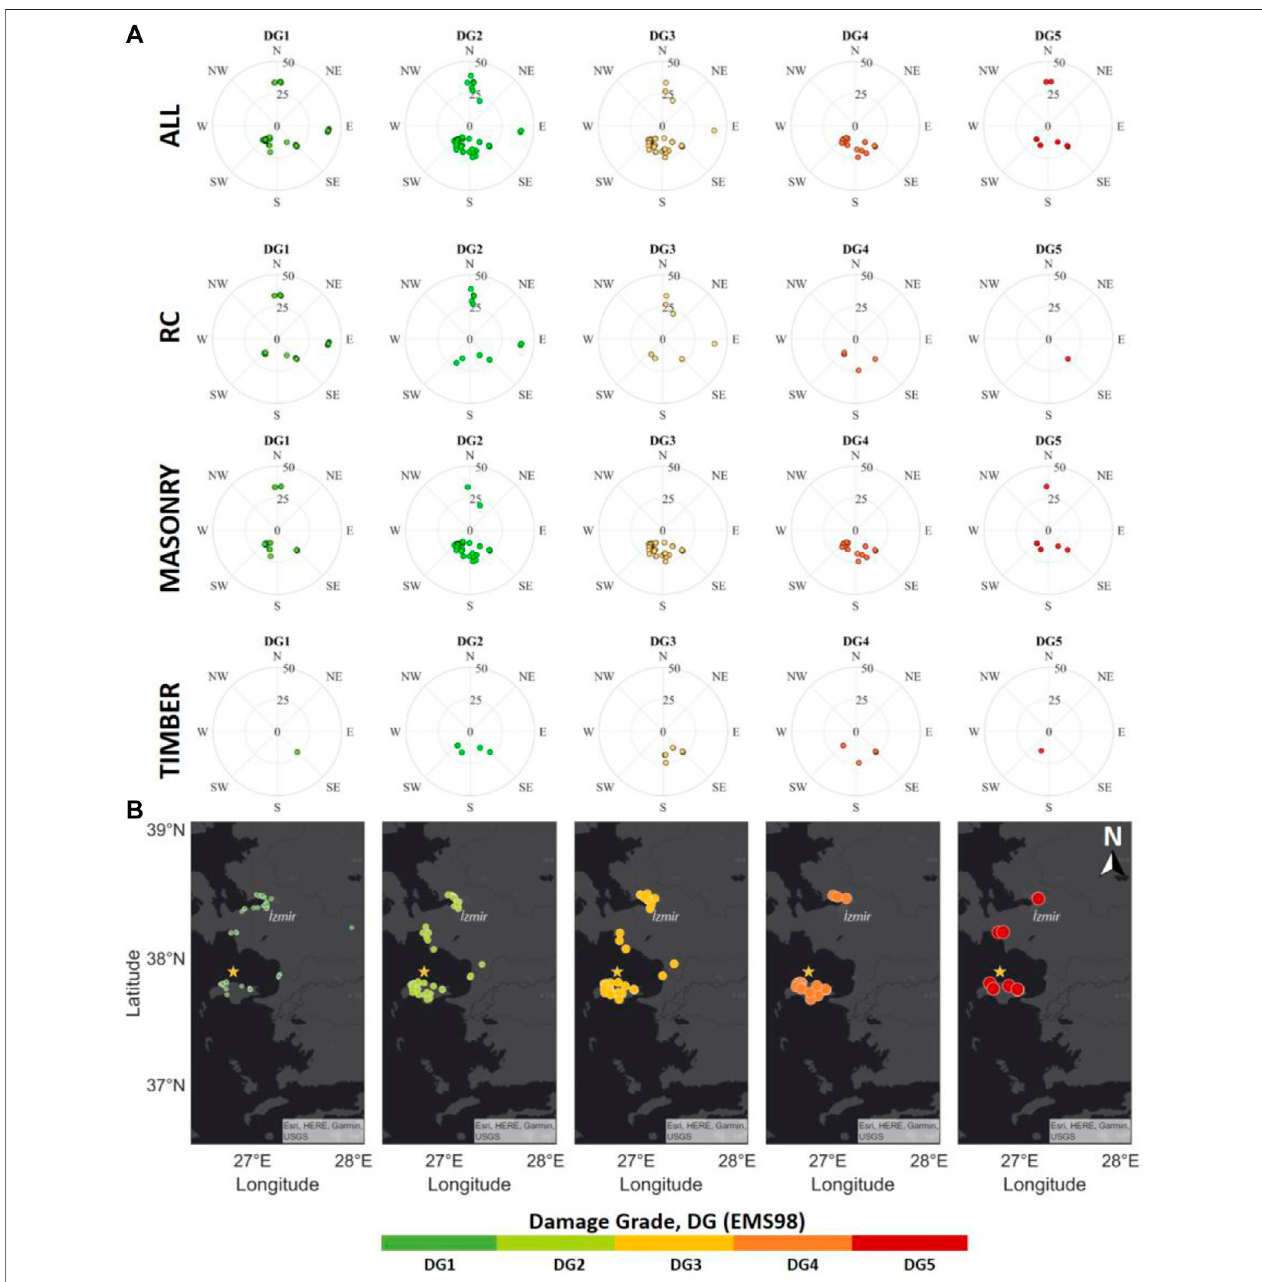
FIGURE 10| (A) Epicentral distancefor different primary structuralsystems and damage levels ( > DG1) and (B) The distribution of the damage levels ( > DG1) ofour surveyed buildings.